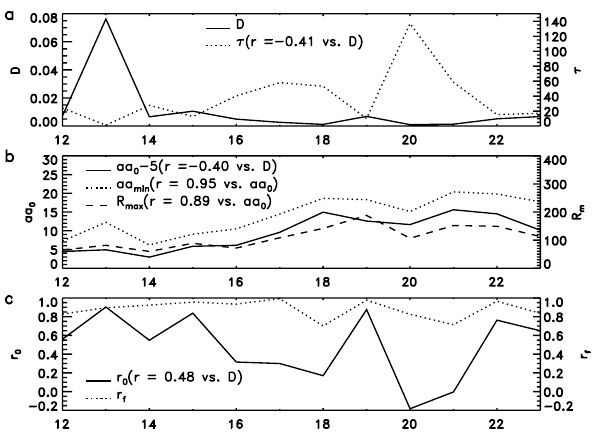
Fig. 7. Time series of aa − 5 (solid) and R z (dashed) since January 1870. The dotted line shows the reconstructed aa series ( aa f ) from each Cycle of 12–23 by Model (10). The correlation coefficients of aa with R z and aa f are r 0 = 0 . 61 and r f = 0 . 95,